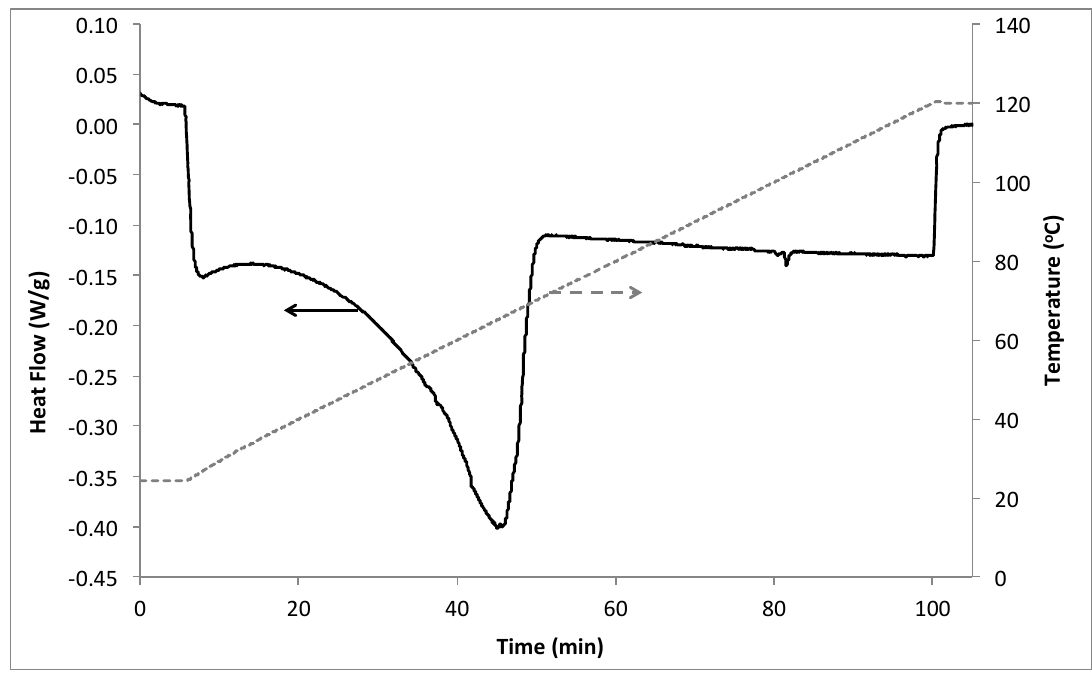
Figure 1. Differential scanning calorimetry (DSC) results for the 1-butyl-3-methylimidazoium methane sulphonate ([bmim][MS]), scan rate is 1 °C/min. Gray dotted line—Temperature of the sample (°C), Black continuous line—Heat Flow (W/g).